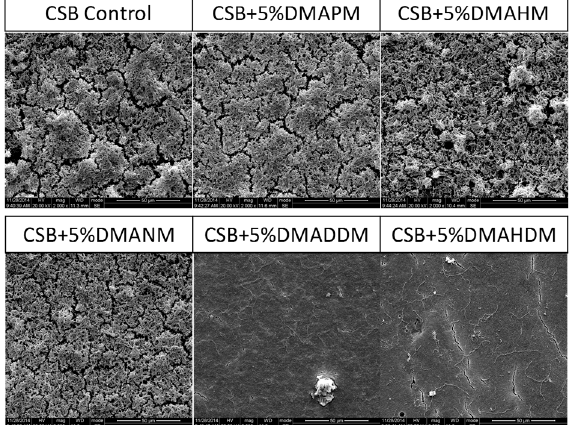
Figure 5. Scanning electron microscopy (SEM) micrographs of three-species biofilms on adhesive (Clearfil SE Bond) disks containing quaternary ammonium methacrylates (QAMs) with different alkyl chain lengths (CL) (CL = 3, 6, 9, 12, and 16) or none.